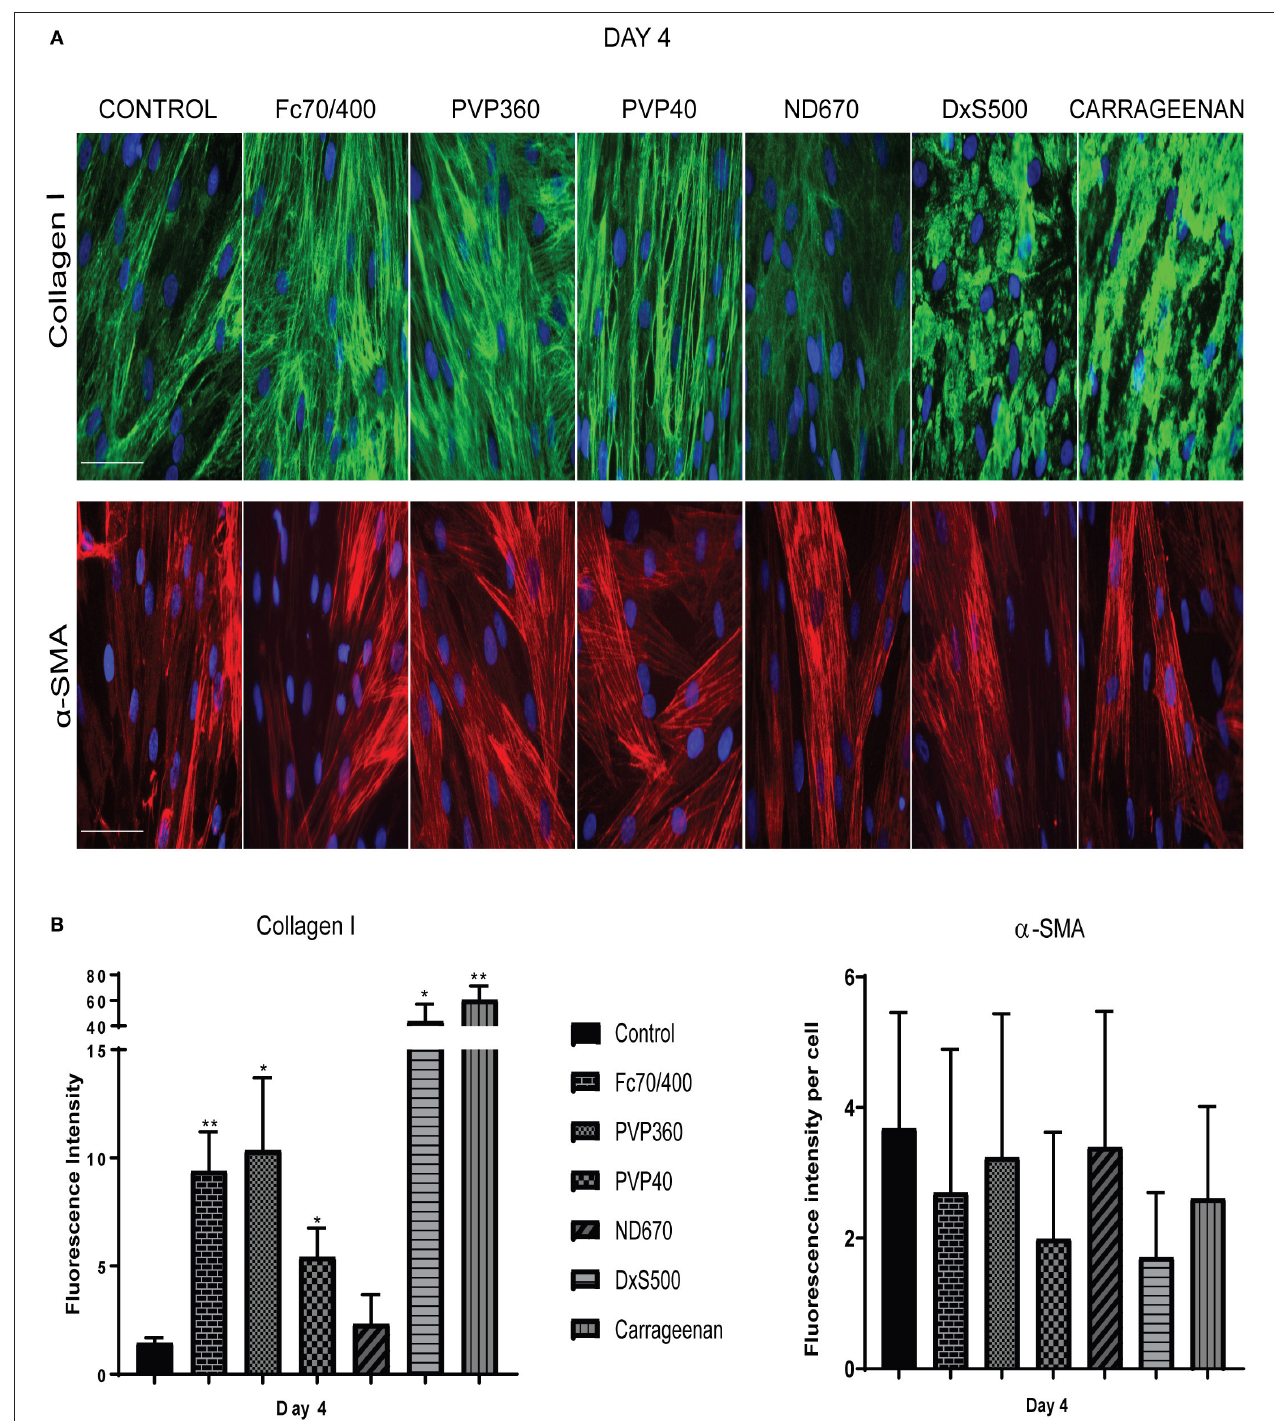
FIGURE 4 | Patterns of collagen I deposition and α -smooth muscle actin cytoskeleton at high magnification as well as its quantification. (A) Immunofluorescence staining of collagen I and α -smooth muscle actin in human dermal fibroblasts ( n = 3) after 96h in the presence of TGF β 1, cultured with macromolecular crowders Fc70/400 mixture, PVP360, PVP40, ND670, DxS500, and CR. Showing 1 FVO; DAPI, collagen I, α -SMA; magnification 40x, scale bars 100 µ m (B) Quantification of collagen I deposition ( n = 5) and α - smooth muscle actin ( n = 3) vs. control. * = P ≤ 0.05; ** = P ≤ 0.01.